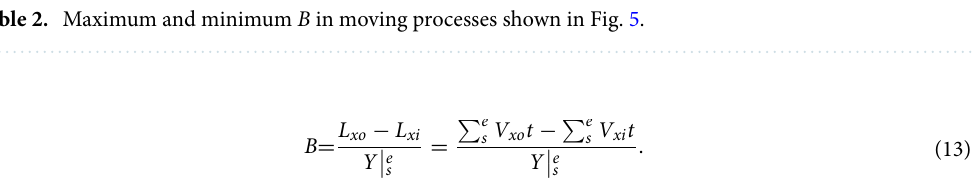
Table 2. Maximum and minimum B in moving processes shown in Fig. 5.